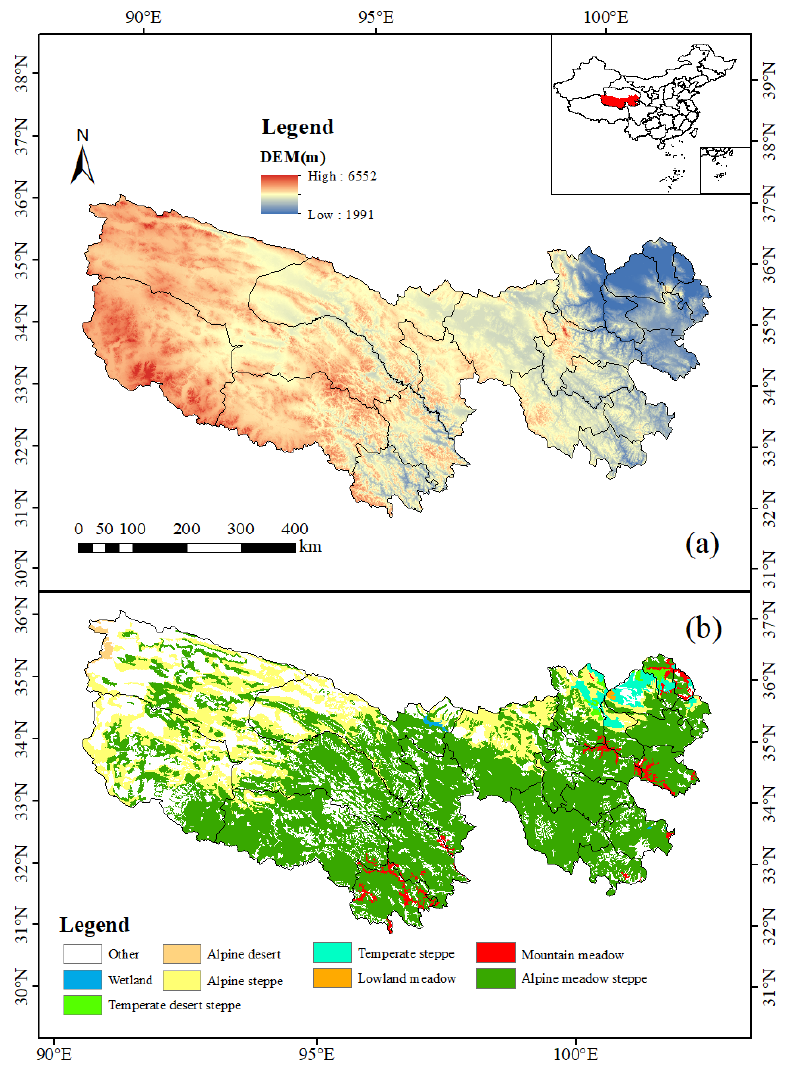
Figure 1. Digital elevation model (DEM) ( a ) and spatial distribution patterns of grassland type ( b ) in the pastoral area of Southern Qinghai Province, China.